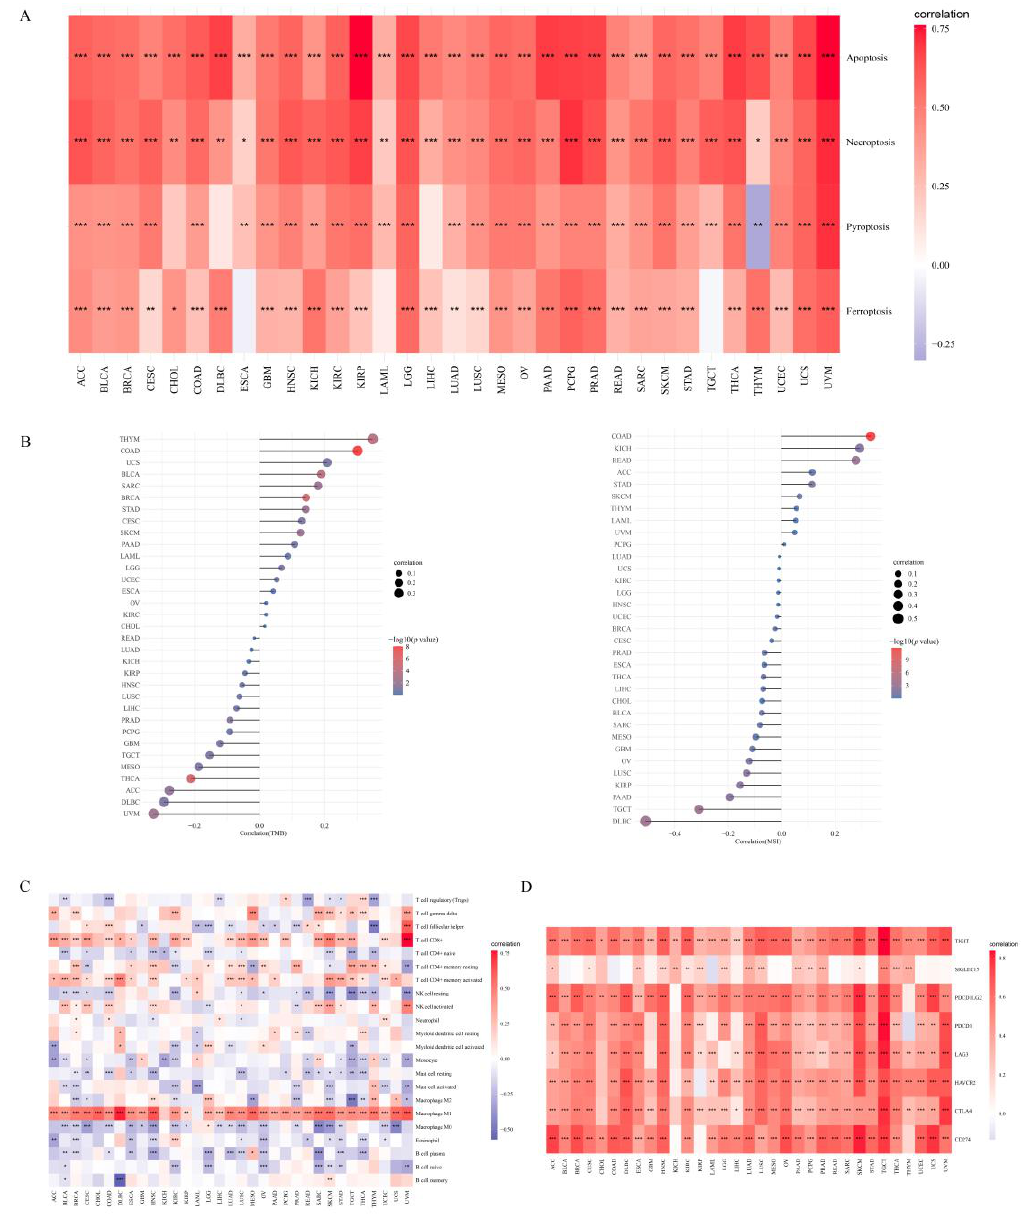
Figure 3. Association of APOL6 levels with cell death burden, immune cell inflation, immune checkpoints, tumor mutation burden (TMB) and microsatellite instability (MSI). ( A , C , D ) Heatmap of the cell death score, CIBERSORT immune score, immune checkpoint-related gene expression and APOL6 expression in multiple tumor tissues. Each box in the figure represents the Spearman correlation analysis between the APOL6 expression and cell death score, CIBERSORT immune score and immune checkpoint-related gene expression in corresponding tumors. ( B ) Spearman correlation analysis of TMB, MSI and APOL6 gene expression. * p < 0.05, ** p < 0.01, *** p < 0.001. To further explore the possible mechanisms of APOL6 in cancers, GO and GSEA analyses were performed. According to the previous analysis, the upregulation of APOL6 was an independent protective factor for improved response and prognosis in melanoma and urothelial cancer (including BLCA). As examples, the GO and GSEA analyses of mel- anoma and BLCA were displayed. As a regulator of lipid metabolism, APOL6 affected metabolic processes such as regulation of intestinal lipid absorption (GO: 1904729), posi- tive regulation of fatty acid transport (GO: 2000193) and lipid binding (GO: 0008289) in